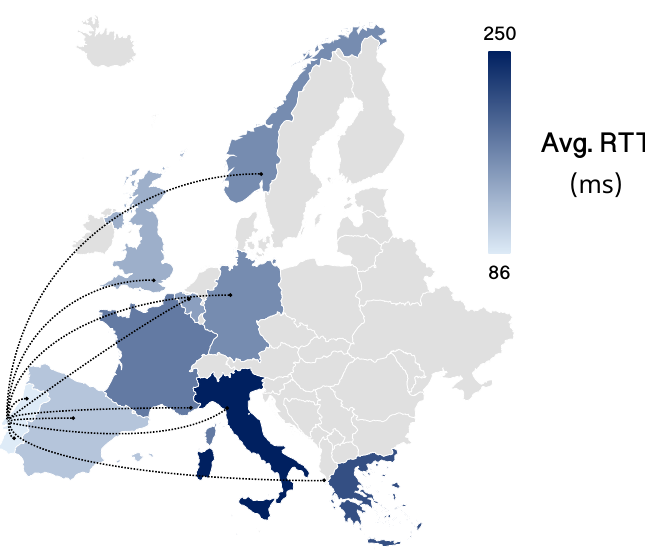
Figure 12. Average RTT in the tested of countries in